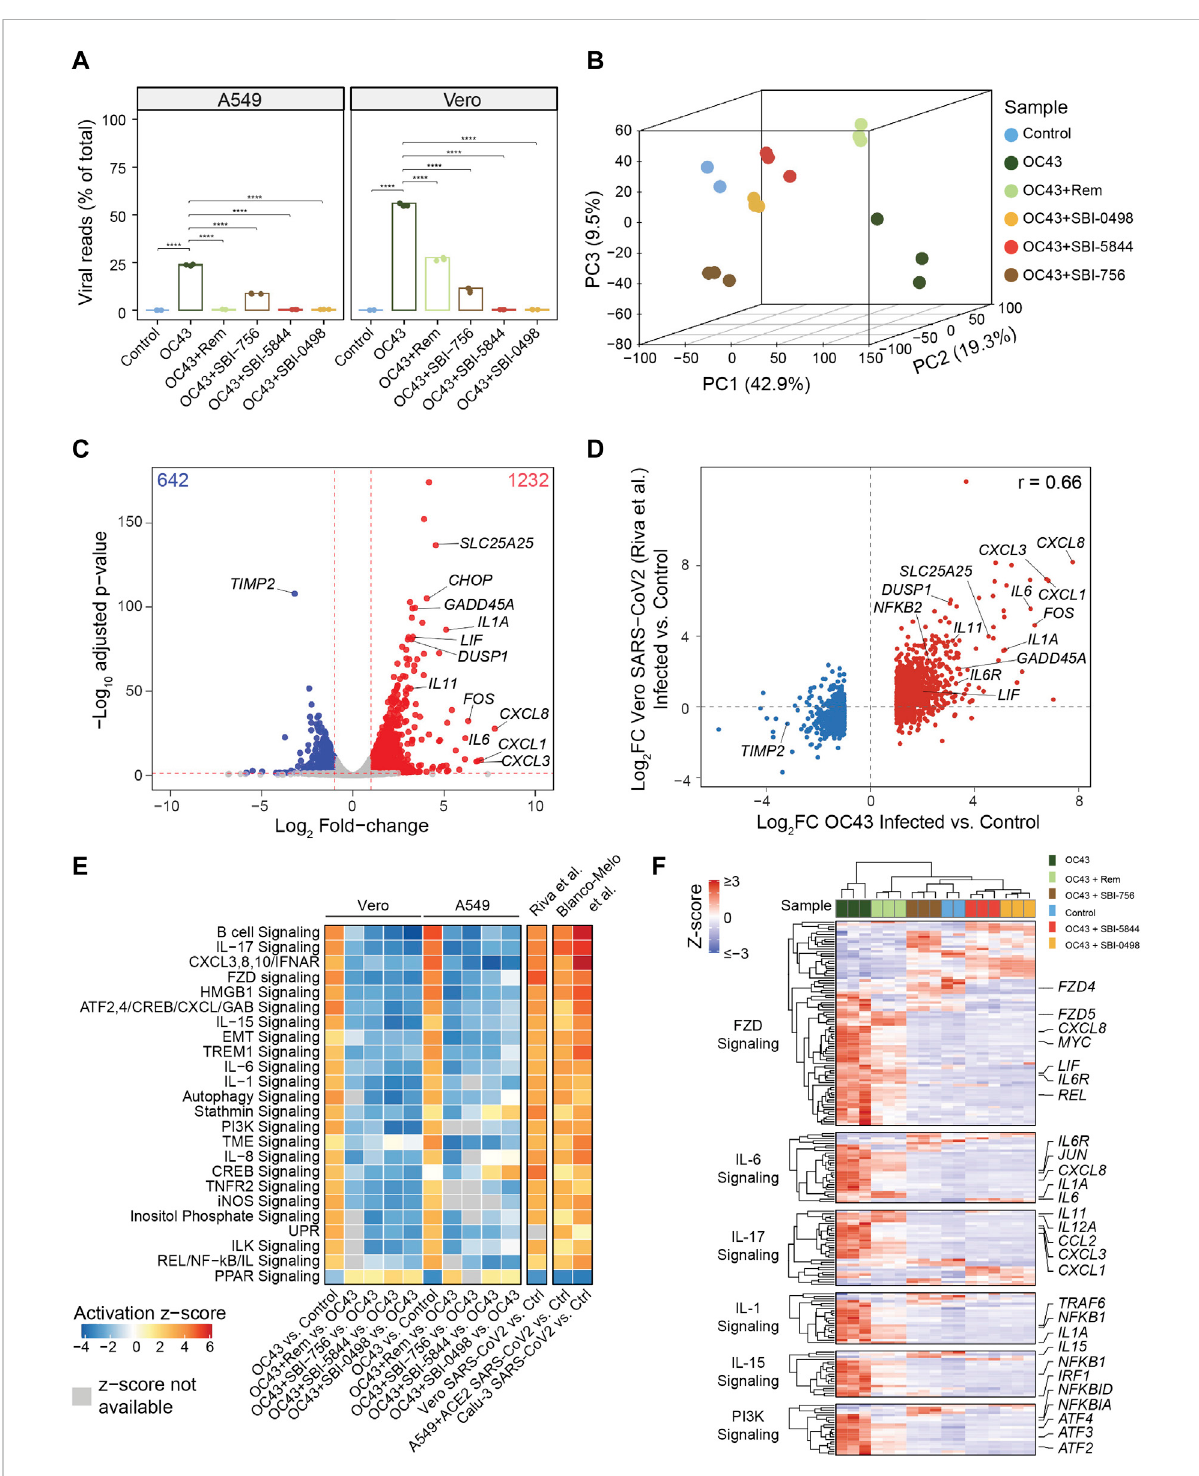
SBI-5844 and SBI-0498 treatment confers transcriptional signatures re fl ective of uninfected cells to OC43 infected cells. (A) RNAseq analysis was performed on RNA extracted from OC43 infected Vero E6 and A549 cells 24 h after treatment with SBI-0498 (10 µM), SBI-5844 (10 µM), SBI- 756 (0.5 µM), and remdesivir (5 µM for Vero E6 cells and 1 µM for A549 cells). Viral replication levels in infected, control, and infected + treated samples assessed by the percentage of viral reads relative to total reads. Reads that did not align to human (A549) and African green